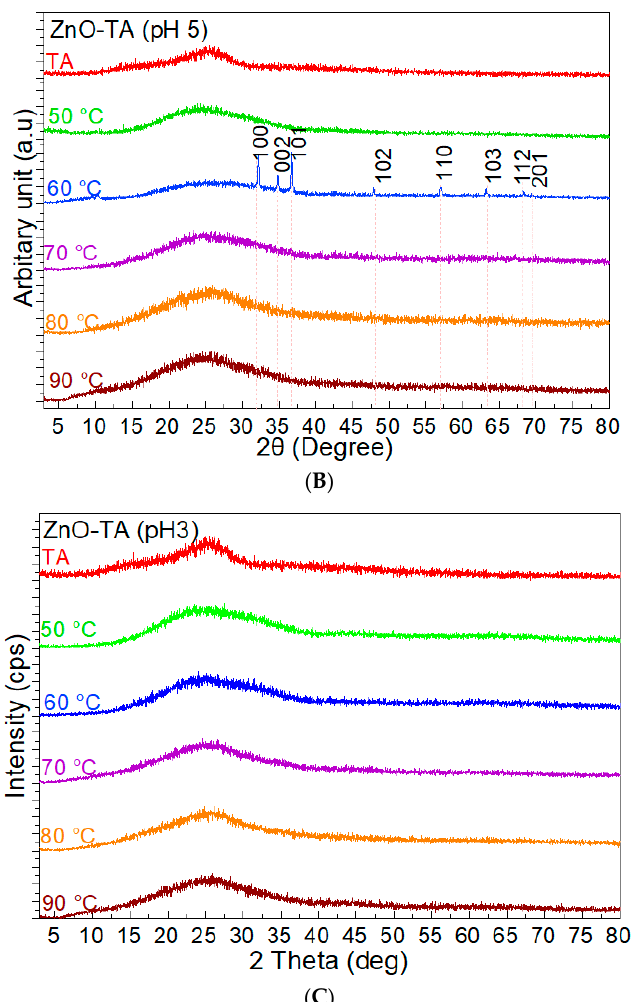
Figure 2. The XRD diffractograms for ( A ) pure ZnO nanostructures synthesized at 50, 60, 70, 80, and 90 ◦ C with ( B ) the XRD peaks of ZnO-TA prepared at pH 5 and ( C ) pH 3 using pure ZnO nanostructures synthesized at 50, 60, 70, 80, and 90 ◦ C. No responses relating to Zn or ZnO have been observed in some of the samples prepared at pH 5 and pH 3, suggesting the domination of TA in all samples.